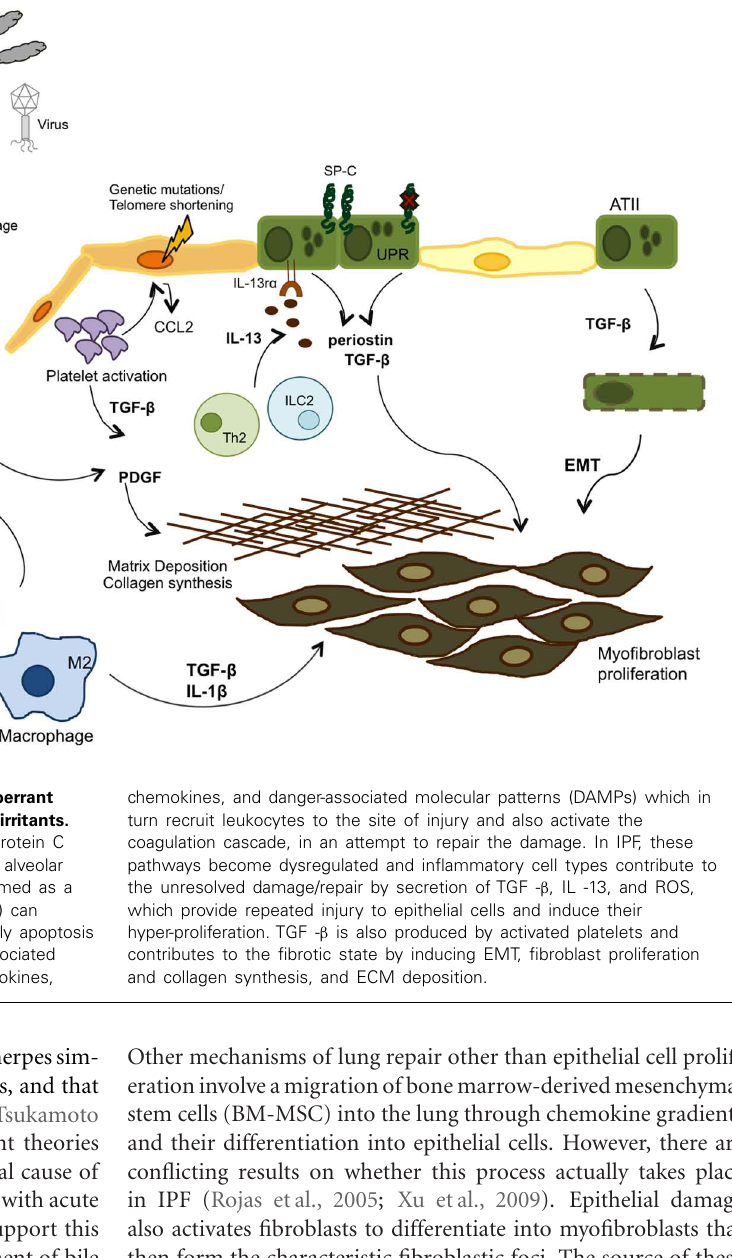
FIGURE 2 |Airway remodeling can be initiated by either aberrant epithelial cell (genetic mutations) or exposure to external irritants. Genetic mutations in the telomerase enzyme and surfactant protein C (SP-C) are associated with a senescence phenotype in type II alveolar cells (ATII), Both these and reactive oxygen species (ROS) formed as a response to injury (cigarette smoke, asbestos, bleomycin, etc.) can activate the UPR response and induce ER stress and ultimately apoptosis in the epithelial cells. These events lead to a senescence- associated secretory phenotype, where injured epithelial cells release cytokines,